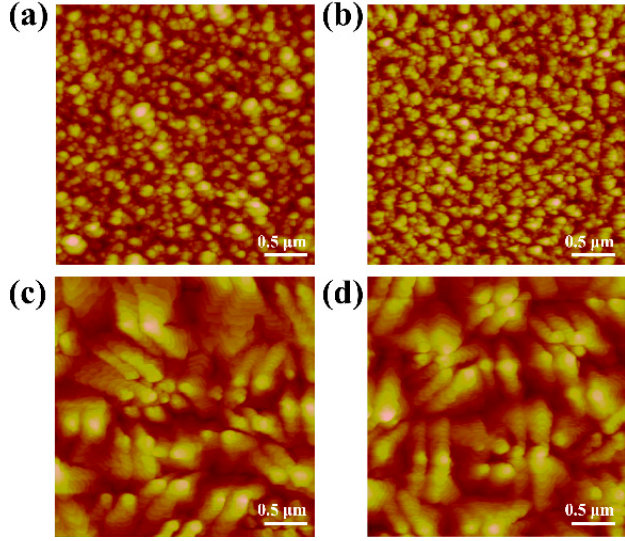
Figure 3. 2D AFM images (3 μ m × 3 μ m) of pentacene films evaporated on the gate dielectrics with rising Ti content: ( a ) sample A, ( b ) sample B, ( c ) sample C, and ( d ) sample D.